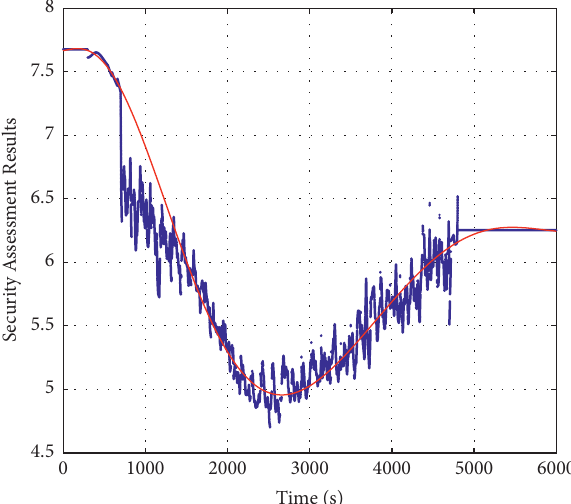
Figure 11: The overall performance of the subway line under scenario 1.